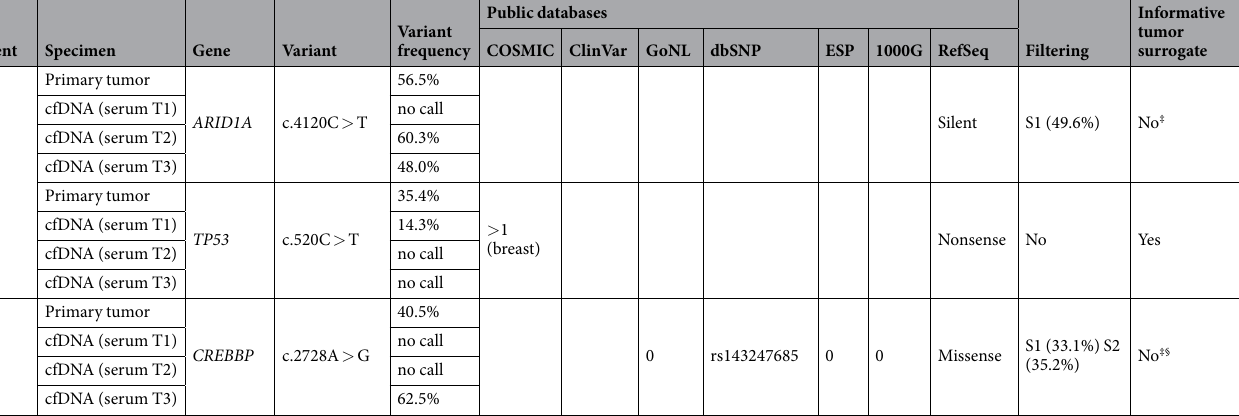
Table 3. Specifics of confirmed somatic variants in primary tumor and serum-derived cfDNA specimens. Further inspection of the confirmed somatic variants in each specimen for each of the ten patients (rows). The columns indicate 1) targeted gene, 2) genomic location followed by the observed substitution as opposed to the reference genome, 3) in case of a call, variant frequency in indicated sample, 4) observation in public databases i.e. COSMIC, ClinVar, GoNL, dbSNP, ESP 1000G and RefSeq, 5) if the variant had been filtered out in patient- matched samples and if so, which samples with what variant frequency and 6) conclusion on the variants as an informative tumor surrogate with reasoning. † Variant frequency similar in all patient-matched samples. ‡ Variant frequency at heterozygosity in all patient-matched samples. § Variant present in public polymorphism